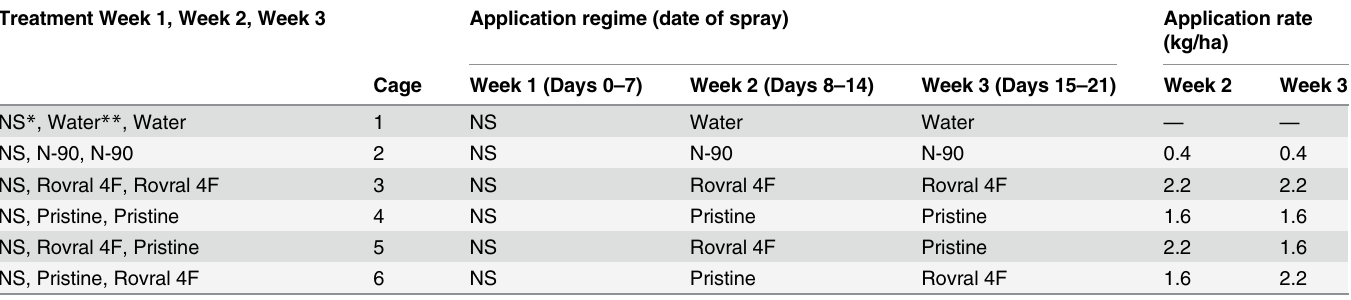
Table 1. Fungicide and adjuvant spray treatments were applied weekly on planted fields of Phacelia tanacetifolia and Sinapis alba in screened field cages where 20 uniquely paint-marked Osmia lignaria females were nesting. Treatment sprays occurred on the evening of days 7 (April 13) and 14 (April 20) when bees were not active. The cage experiment was conducted at The Wonderful Company in Lost Hills, California in 2011.